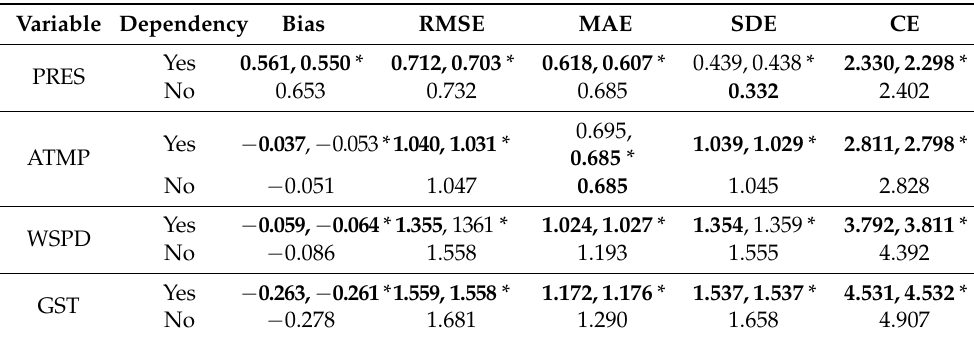
Table 5. Prediction errors with dependent and independent